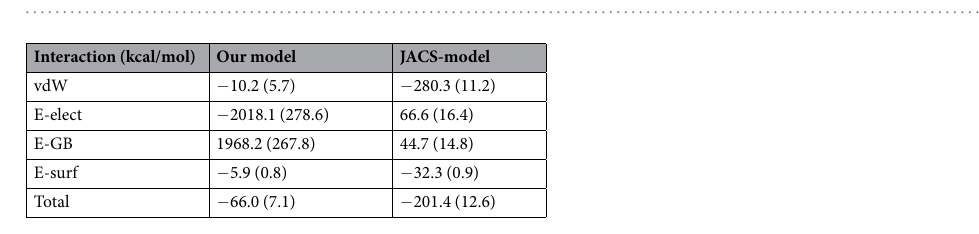
Figure 3. Conformation of our two-fold model and the JACS model. Initial ( a ) and final ( b ) conformation (after 200 ns of molecular dynamics simulation) of the two-fold model of A β 11–42 predicted by us in previous work 18 . The corresponding configurations for the two-fold model derived by Colvin T. et al . 15 are shown in ( c , d ). Color map of residues: red-Q15, grey-L17/L34, blue-M35.